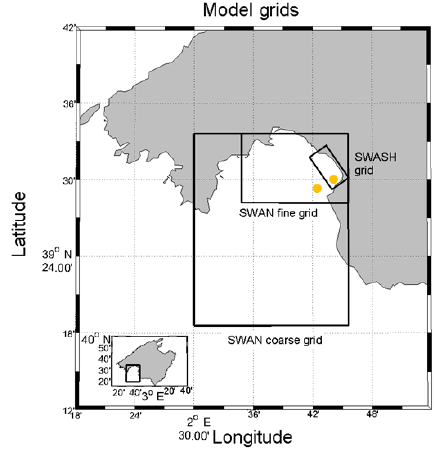
Figure 4. SWAN and SWASH computational domains for Playa de Palma. Yellow dots indicate the locations of the shallow water wave buoy and